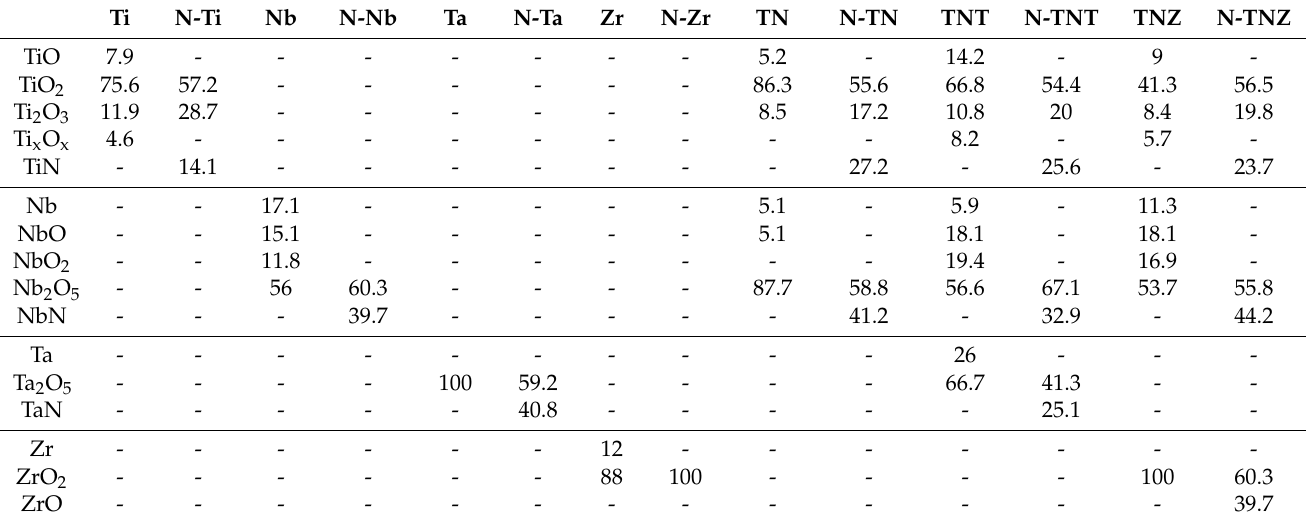
Table 2. Surface composition analysis of the samples, determined by XPS (atomic